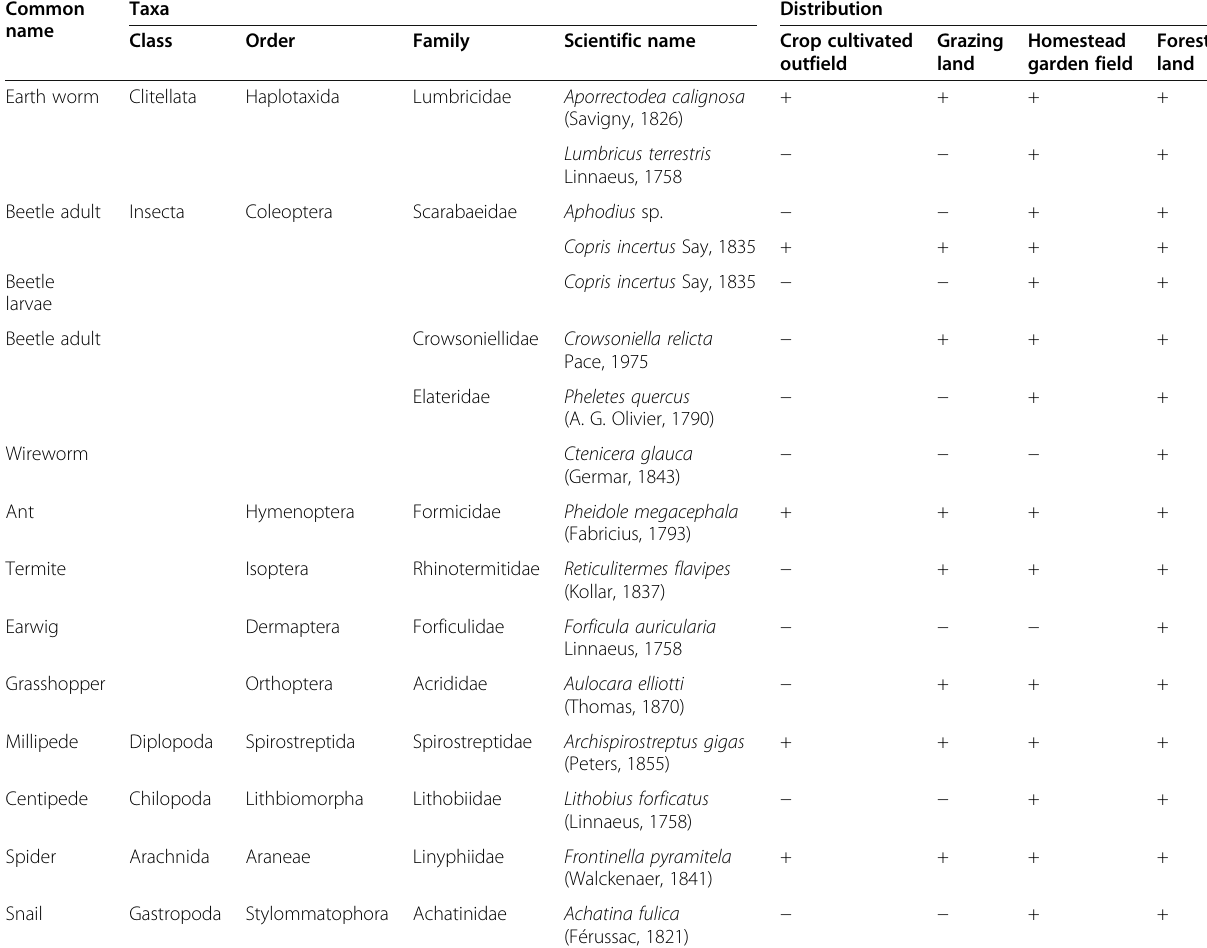
Table 1 Composition and distribution of soil invertebrate macro-fauna in different land use types at Shenkolla watershed, south central